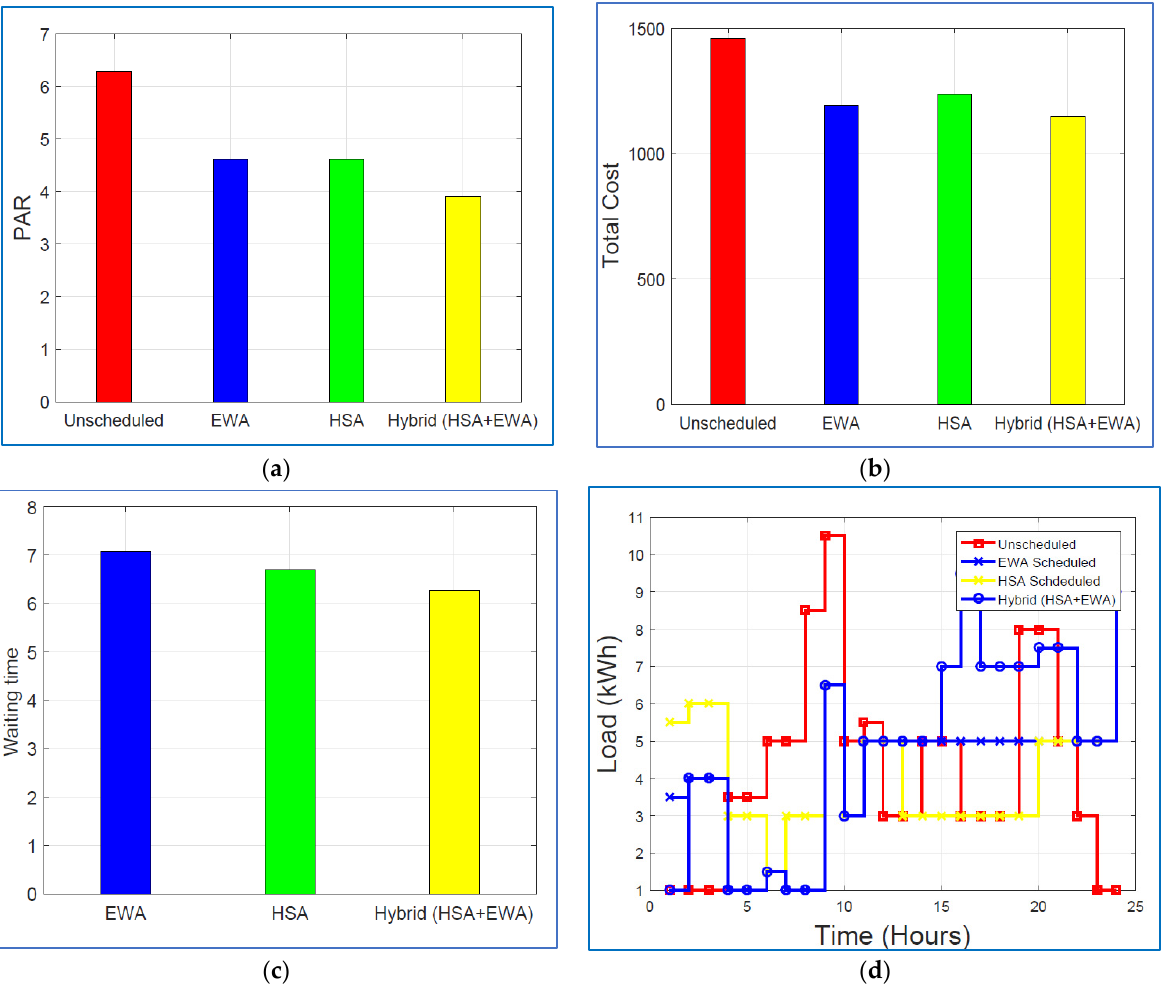
Figure 4. ( a ) 60 Minute OTI for PAR. ( b ) 60 Minute OTI for Total Cost. ( c ) 60 Minute OTI for User Figure 4. ( a ) 60 min OTI for PAR. ( b ) 60 min OTI for Total Cost. ( c ) 60 min OTI for User Comfort. Comfort. ( d ) 60 Minute OTI for Total Load. ( d ) 60 min OTI for Total